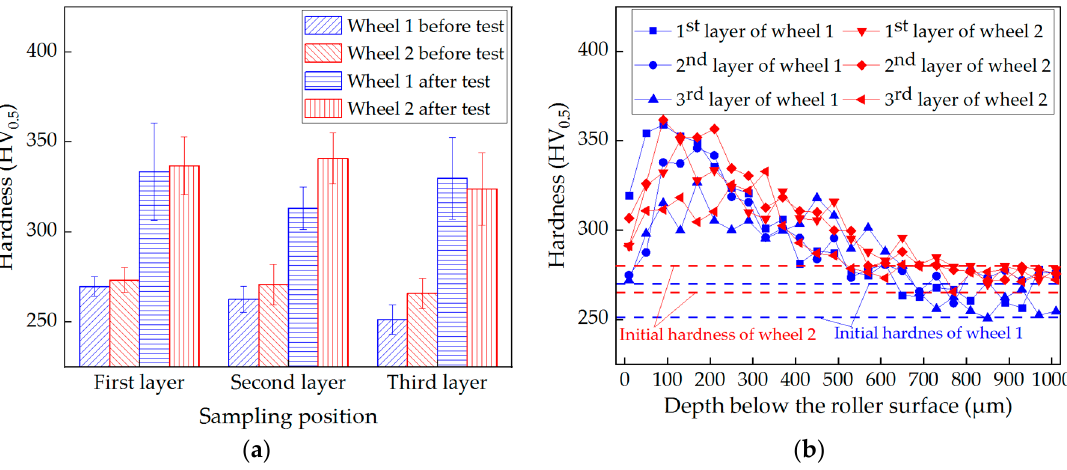
Figure 4. Hardness of wheel 1 (standard wheel) and wheel 2 (improved wheel): ( a ) surface hardness